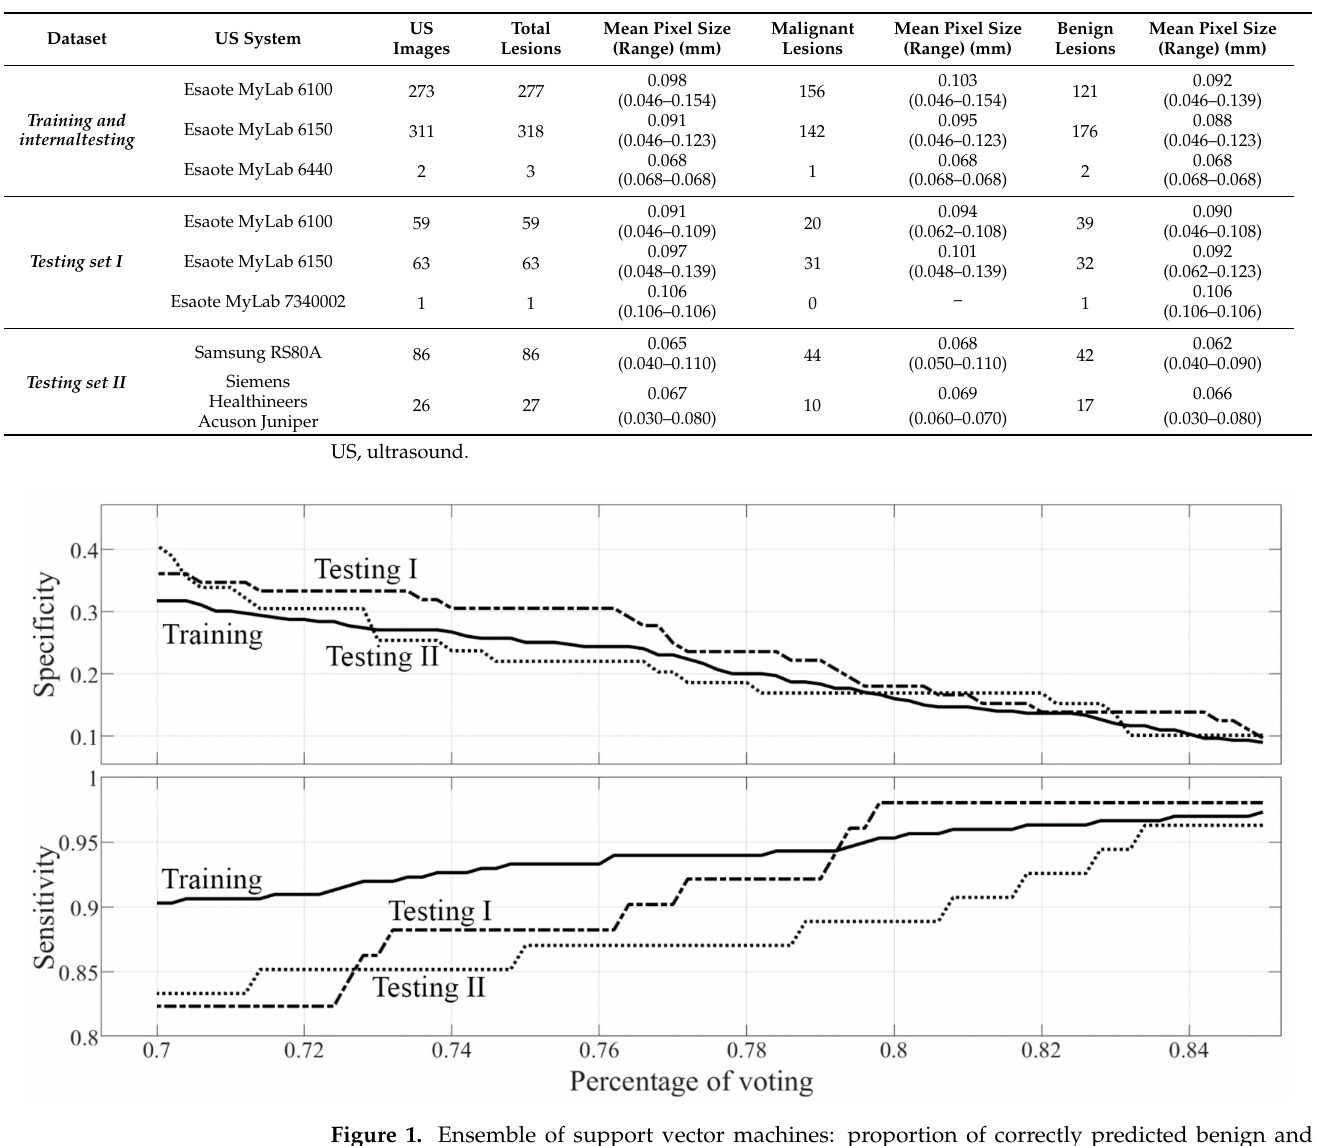
Table 2. Technical details and composition of the three image sets.